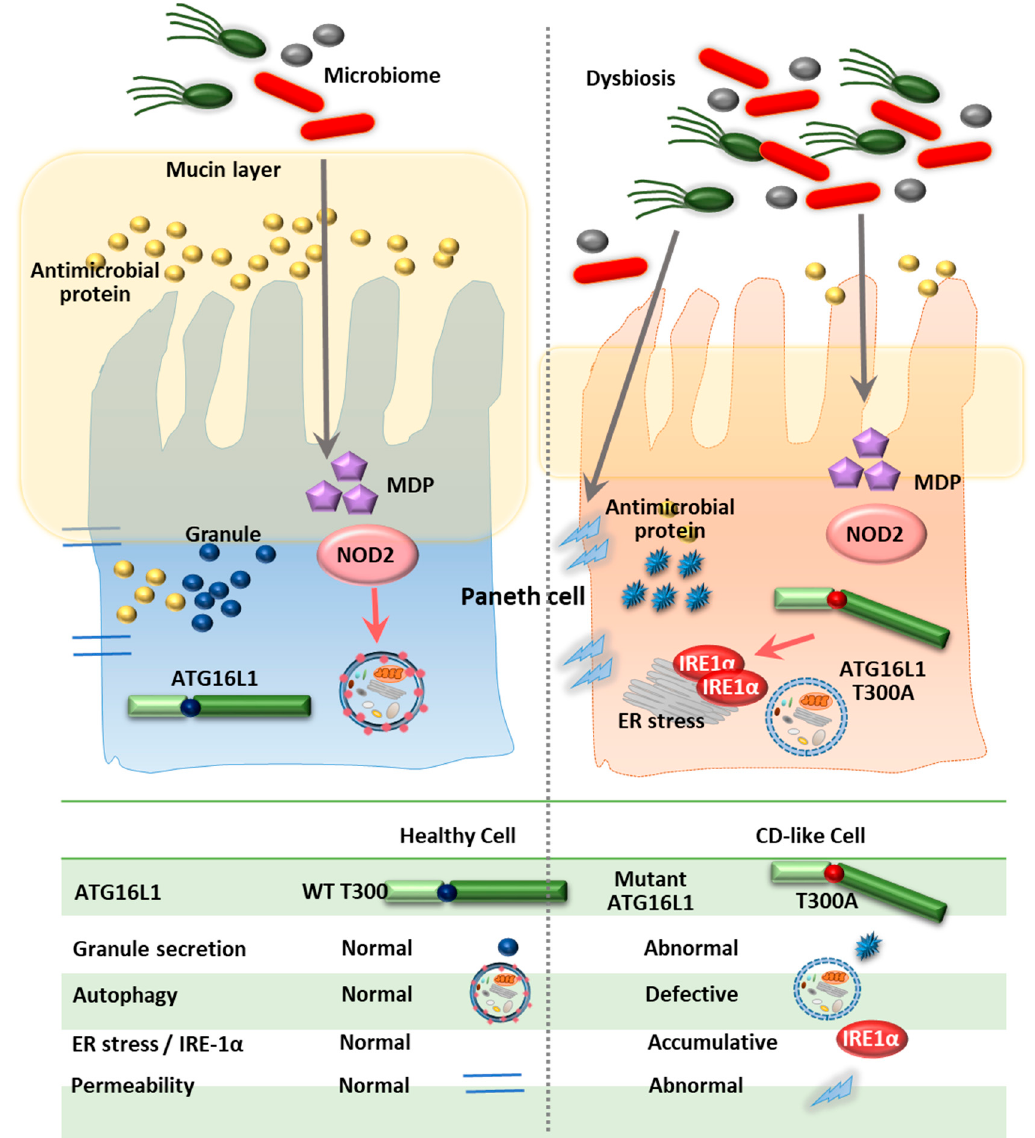
Figure 3. Summary diagram showing the role of ATG16L1 in the Crohn’s disease. The left panel demonstrates the normal host defense mechanism against intracellular pathogens. Healthy cells exhibit normal granule secretion, autophagic activity, ER stress response and permeability. The right panel shows the ATG16L1 T300A variant cells defective in granule secretion, autophagy process, IRE1 α degradation and tight junction barrier function.